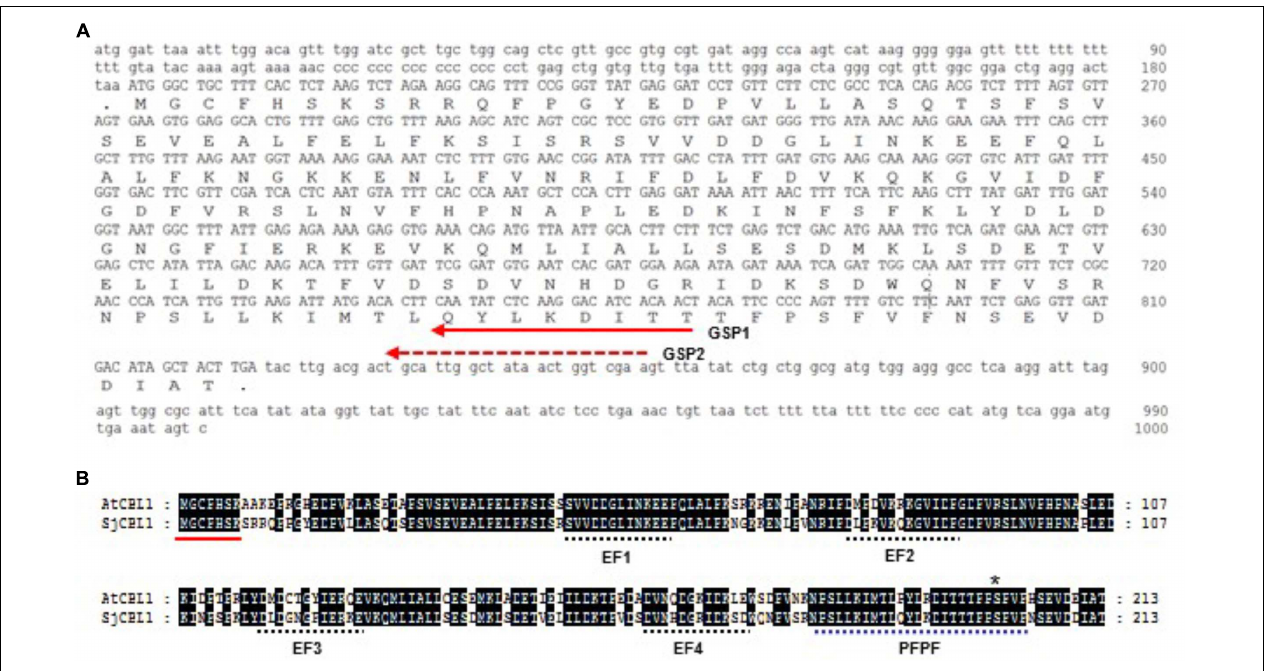
FIGURE 2 | Sequence analysis of the SjCBL1 cDNA clone. (A) Nucleotide sequence of the isolated SjCBL1 cDNA. Open reading frame is shown in uppercase, whereas the 5 (cid:48) and 3 (cid:48) untranslated regions are indicated in lowercase. The dashed and solid lines with an arrow indicate two nested reverse primers (GSP1 and GSP2) used for 5 (cid:48) RACE. (B) Amino acid sequence alignment of Arabidopsis CBL1 (AtCBL1) and Sedirea Japonica CBL1 (SjCBL1). Alignment was generated by using Lasergene MegAlign Program (DNASTAR) and visualized with GeneDoc version 2.7. Identical amino acid residues are shaded black. A solid line indicates the canonical myristoylation motif (MGXXXSK) and dashed lines represent the EF-hand or PFPF motifs. The asterisk mark represent the serine residue phosphorylated by CIPK23.